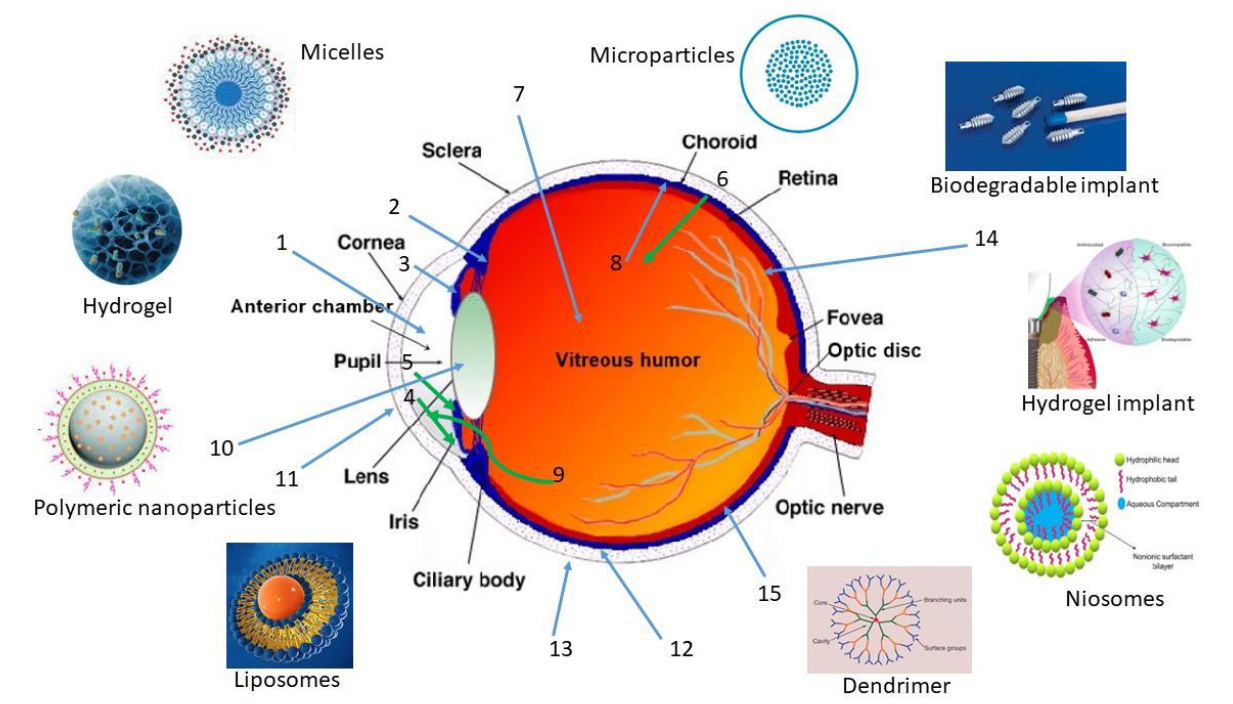
Figure 1. Schematic representation of various formulation approaches and routes of administration to the ocular tissues. 1. Transcorneal permeation into the anterior chamber, 2. Noncorneal drug permeation across conjunctiva to sclera into anterior uvea, 3. Drug distribution into anterior chamber from blood stream through blood aqueous barrier, 4. Drug elimination from anterior chamber by aqueous humor to trabecular meshwork and Schlemm’s canal, 5. Elimination of drug from aqueous humor into systemic circulation across blood aqueous barrier, 6. Distribution of drug from blood into posterior segment across the blood retinal barrier, 7. Intravitreal route, 8. Drug elimination from vitreous via posterior route across blood retinal barrier, 9. Elimination of drug from vitreous via anterior route to posterior chamber, 10. Intracameral route, 11. Intrastromal route, 12. Subconjunctival route, 13. Subtenon route, 14. Suprachoroidal route, 15. Subretinal route.